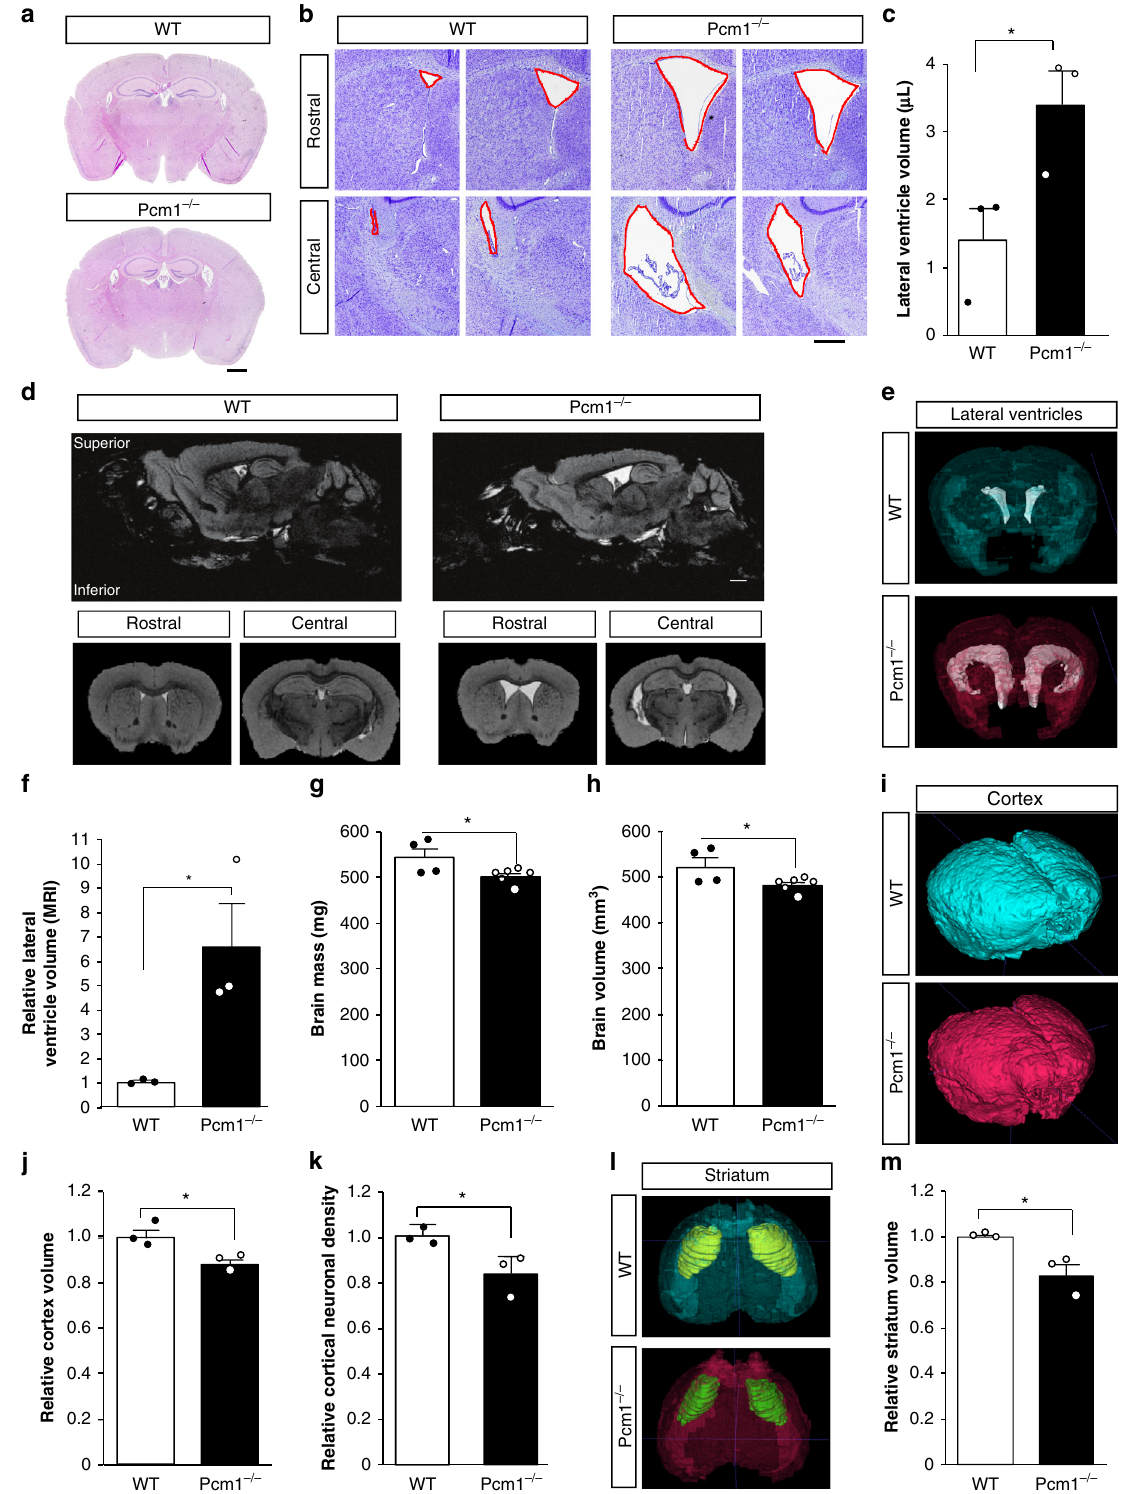
Fig. 1 Neuroanatomical defects in adult Pcm1 − / − mice. a Representative H&E sections from control and Pcm1 − / − brains. Scale 1 mm ( b ) Representative Cresyl violet histological sections from two WT and two Pcm1 − / − brains depicting enlarged ventricles in the mutant. c Lateral ventricle volume by stereology ( N = 3; p = 0.047). Scale 0.4 mm ( d ) Representative slices from adult WT and Pcm1 − / − brain MRIs. Scale 0.6 mm ( e ) Representative volumetric views of the lateral ventricles. f Lateral ventricle volume ( N = 3; p = 0.036). g Total brain size ( N = 4 and 6); p = 0.05). h Total brain volume ( N = 4 and 6; p = 0.05). i Representative volumetric views of the cortex. j Cortex volume ( N = 3; p = 0.035). k Cortical neuron density ( N = 4; p = 0.045). l Representative volumetric views of the striatum (anterior view, shown with transparent cortex). m Striatal volume ( N = 3; p = 0.027). Data presented as mean ± SEM; * p < 0.05, WT vs. Pcm1 − / − . Two-sided t -tests, without adjustments. Source data and detailed statistical information are provided as a Source Data